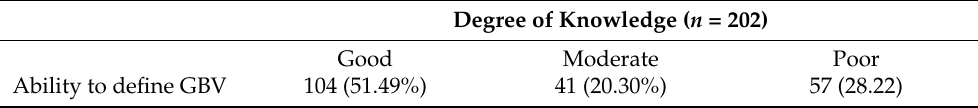
Table 2. Knowledge of gender-based violence